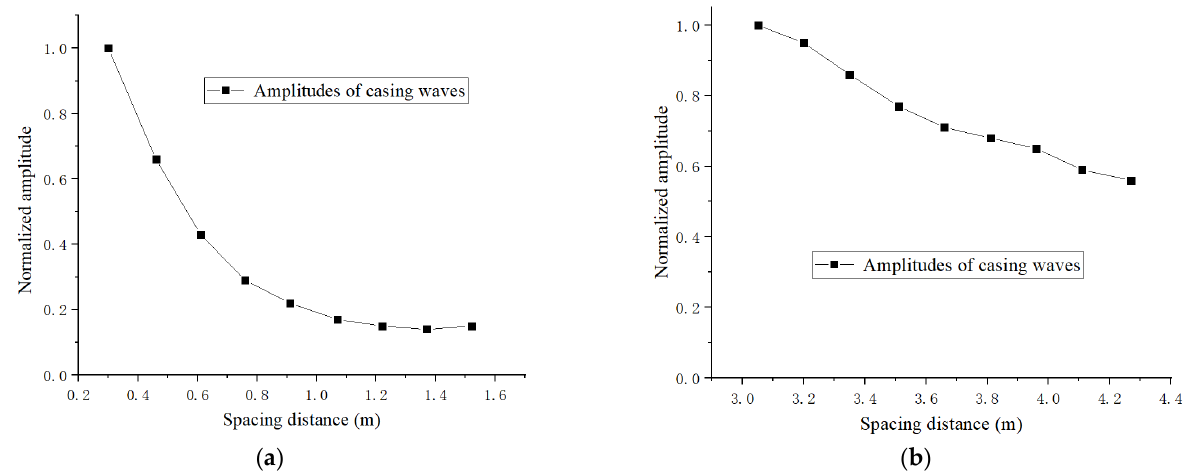
Figure 2. Normalized amplitudes of the casing waves excited by the same transmitting transducers and received by the same receiving transducers, while the propagation lengths are different short ( a ) and long ( b ) spacing distances.